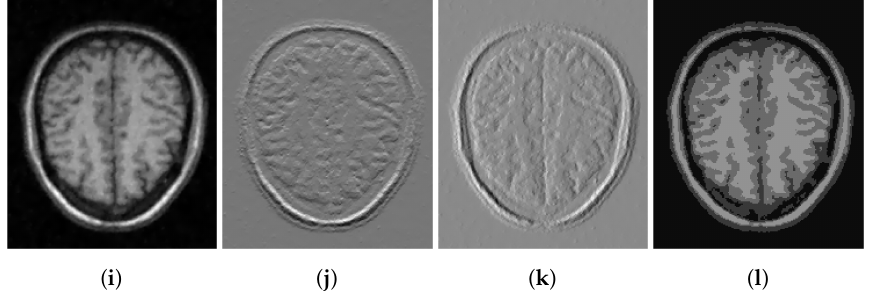
Figure 5. MRI segmentation: ( a ) Clean image. ( b ) Noisy image used as input to the models. ( c ) Output of CCZ. ( d ) CCZ after thresholding. ( e ) Output of CNC. ( f ) CNC after thresholding. ( g ) Output of T-ROF. ( h ) T-ROF after thresholding. ( i ) Output g of our model. ( j ) Output G x of our model. ( k ) Output G y of our model. ( l ) Ours after